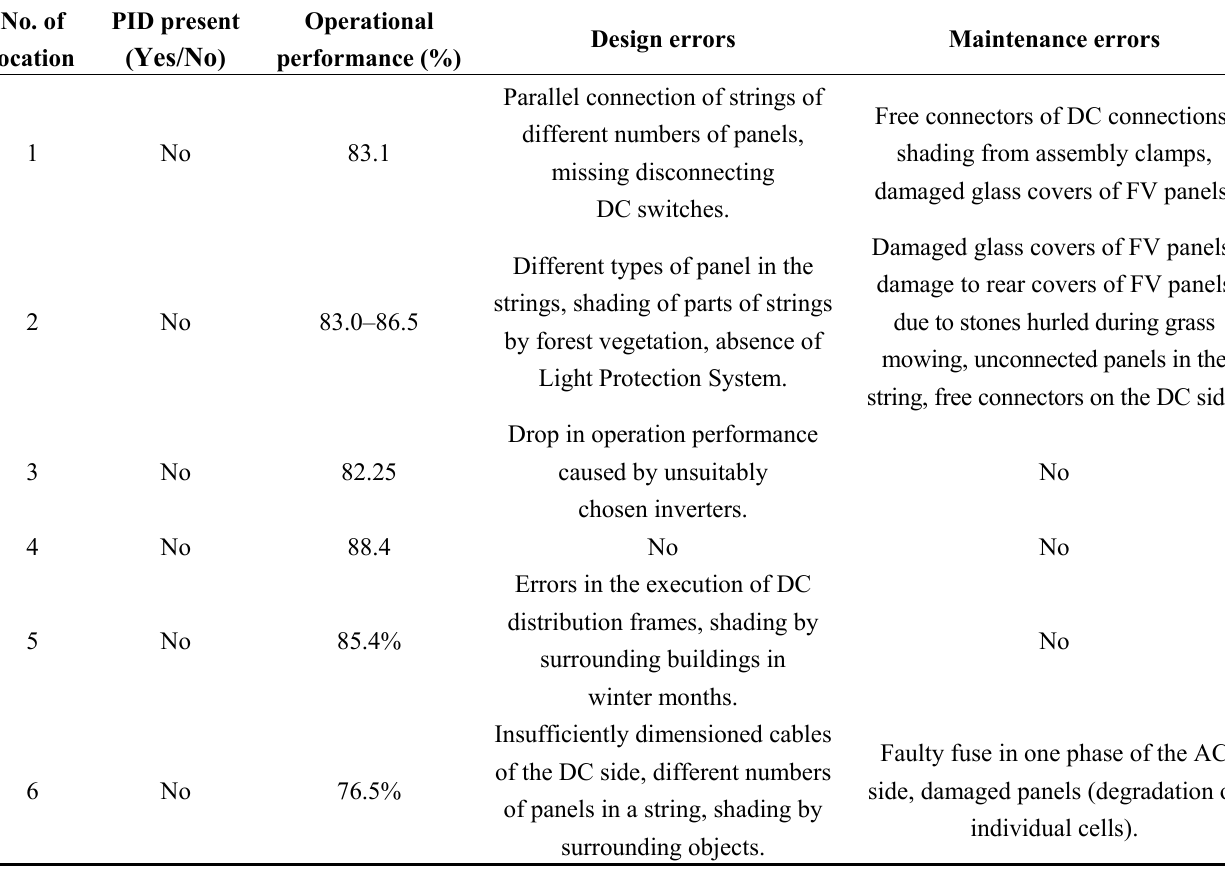
Table 5. Measurement results in individual